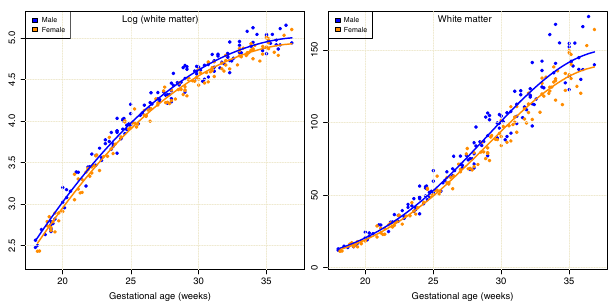
Fig. 5 Plots of the male (blue) and female (orange) log-transformed datasets with separate mixed-effects estimates for each in (left) and then transformed back into the measurement domain (right). Note in the raw measures the increase in variance with age due to accumulated developmental differences, and the more age-independent variance in the log measurement domain. In the log domain there is a consistent fi xed separation of the volume estimates. This corresponds in the right plot to a fi xed fractional difference in volume estimates from female to male maintained throughout the gestational period (see Table 1 for speci fi c